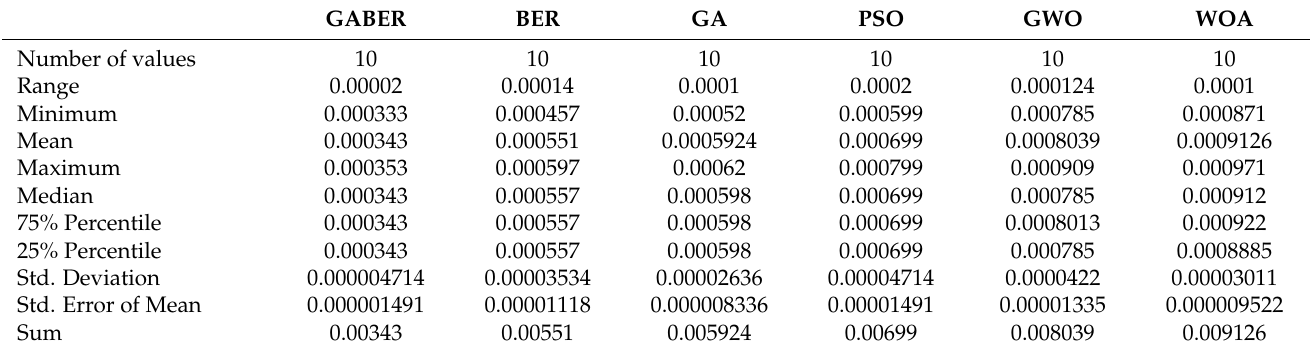
Table 9. Statistical analysis of the prediction results achieved by the proposed optimized stacked ensemble model applied to the wind speed dataset.